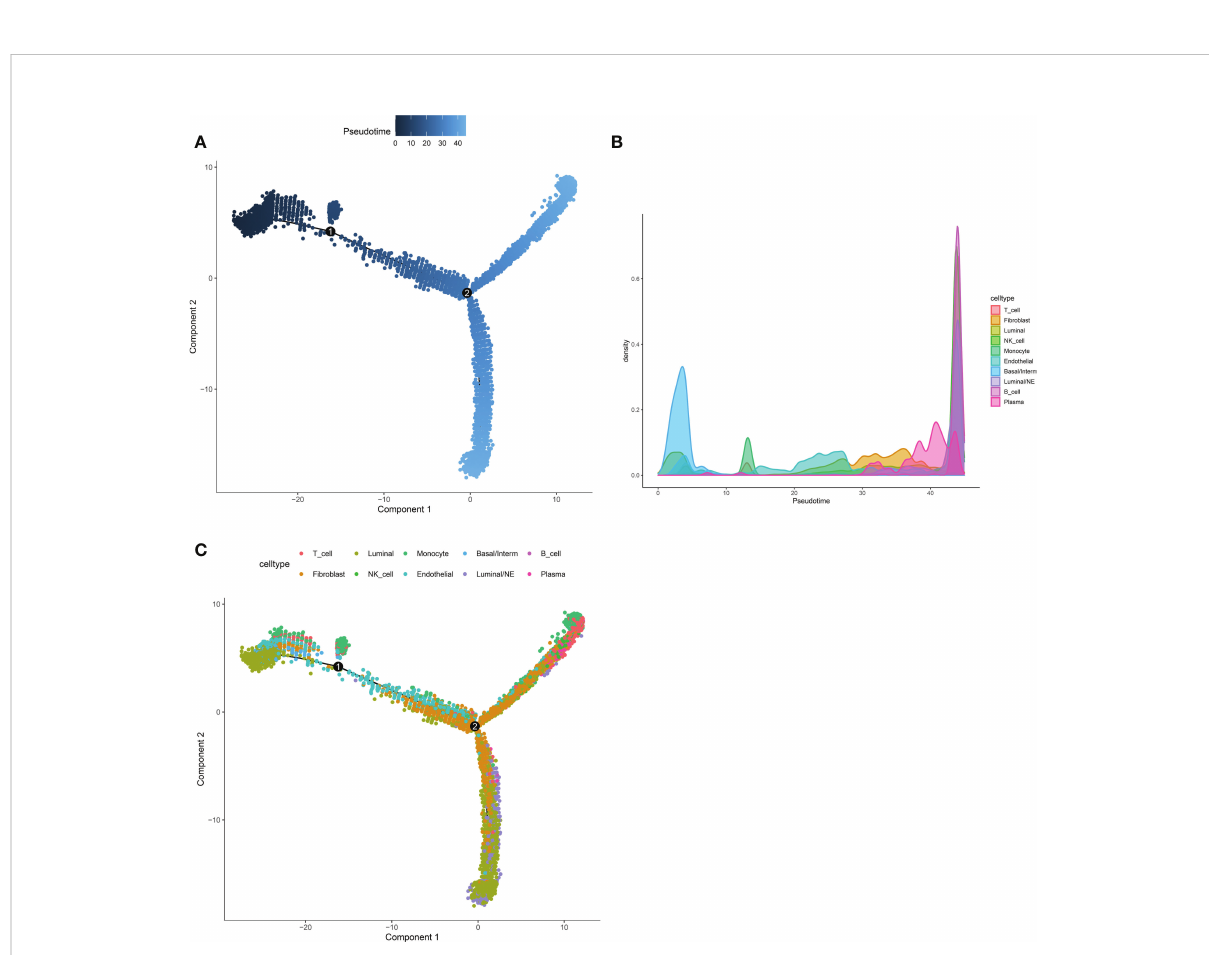
FIGURE 4 Pseudotime and trajectory analysis revealed the tendency curve among various cell types. (A) The pseudo time is shown as the depth of the color, the darker the blue, the smaller the pseudo time, which means that the cells appear earlier. The dots above represent cells. (B, C) Pseudotime-Density diagram demonstrated cells including immune cells (such as NK-T cell, B cell, Plasma) as well as Luminal/NE cells gather around the destination. X-axis means the value of principal component 1 (the fi rst principal direction of maximum sample change) and Y-axis means the value of principal component